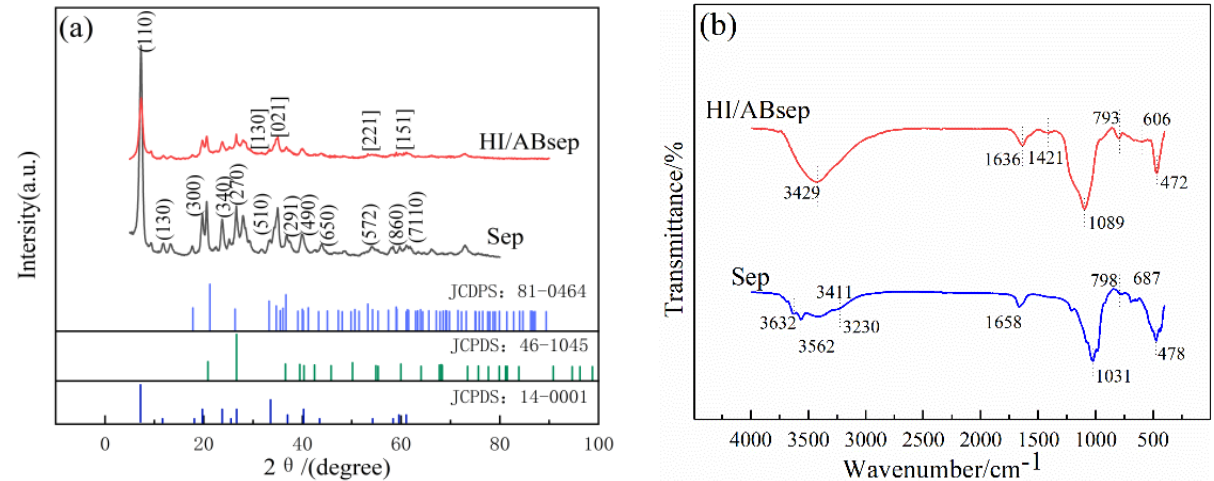
Figure 3. PXRD ( a ) and FTIR spectrum ( b ) of Sep and HI/ABsep. The red line in Figure 3a represents the XRD image of HI/ABsep, the black line is the XRD image of Sep, and the light blue refers to the data image corresponding to JCPDS:81-0464; Green is the data image corresponding to JCPDS:46-1045; The dark blue is the data image corresponding to JCPDS:14-0001. The red line in Figure 3b is the image produced by the infrared spectral data of HI/ABsep, and the black line is the infrared spectrum of Sep.